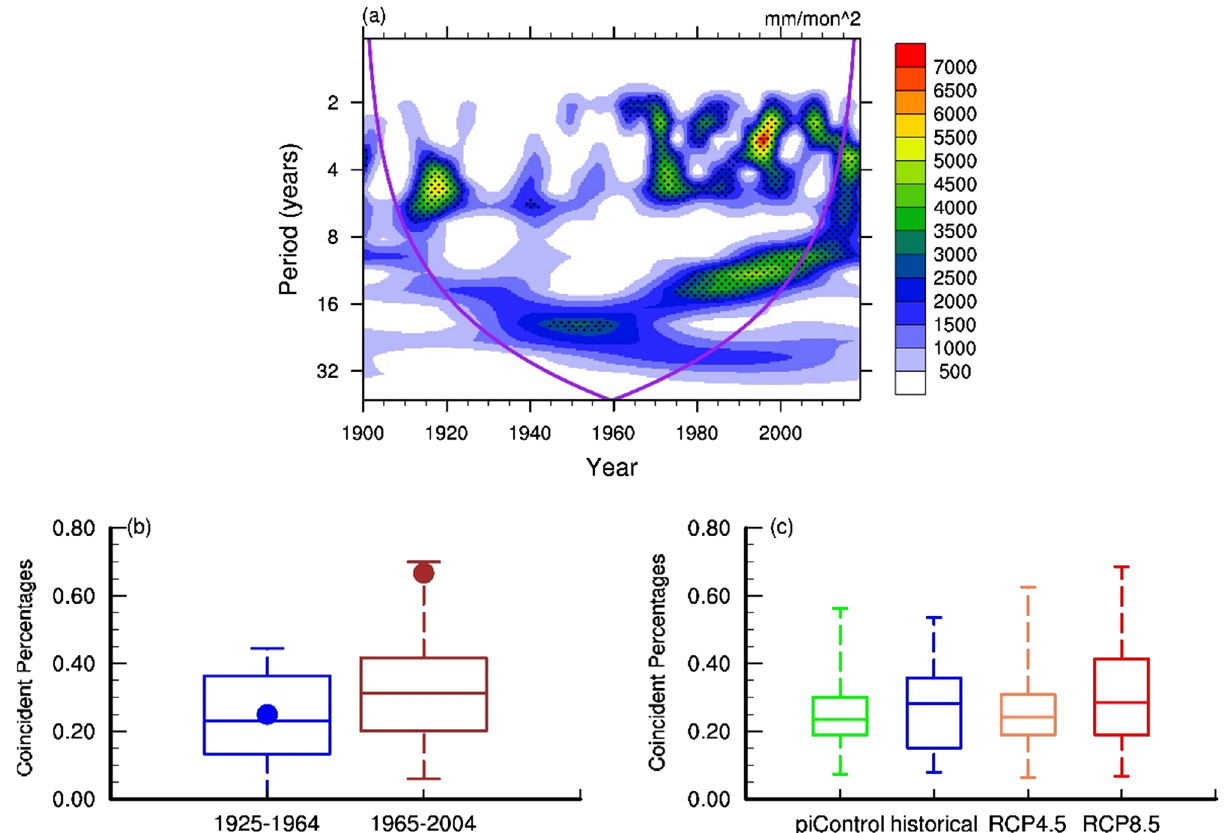
Figure 4. ( a ) Wavelet power spectra of MC precipitation during SO, areas where the 95% confidence interval is exceeded are stippled. ( b ) Box plot of the coincident El Niño-pIOD percentages from 18 CMIP5 historical simulations for two periods (1925–1964 vs 1965–2004). The coincident percentage is defined as the ratio of the number of coincident events to the sum of El Niño-only events, pIOD-only events, and coincident El Niño- pIOD events for each model. The results from observations were dotted in blue and red, respectively. ( c ) same as panel ( b ), but for the 18 CMIP5 piControl, historical, RCP4.5 and RCP8.5 simulations. The figures were plotted by NCAR Command Language (NCL) version 6.5.0 (https:// www. ncl. ucar.